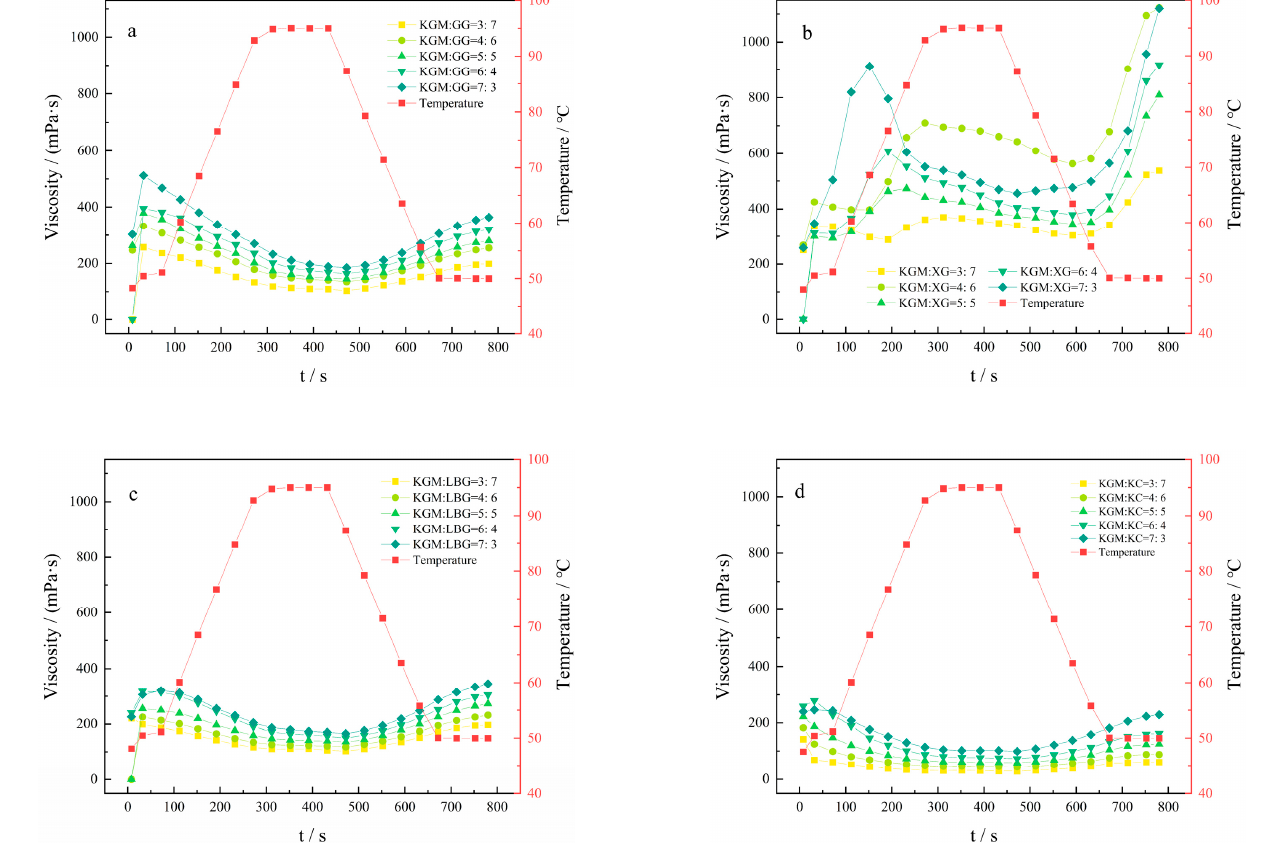
Figure 6. Viscosity curves of 5 kinds of thickeners.